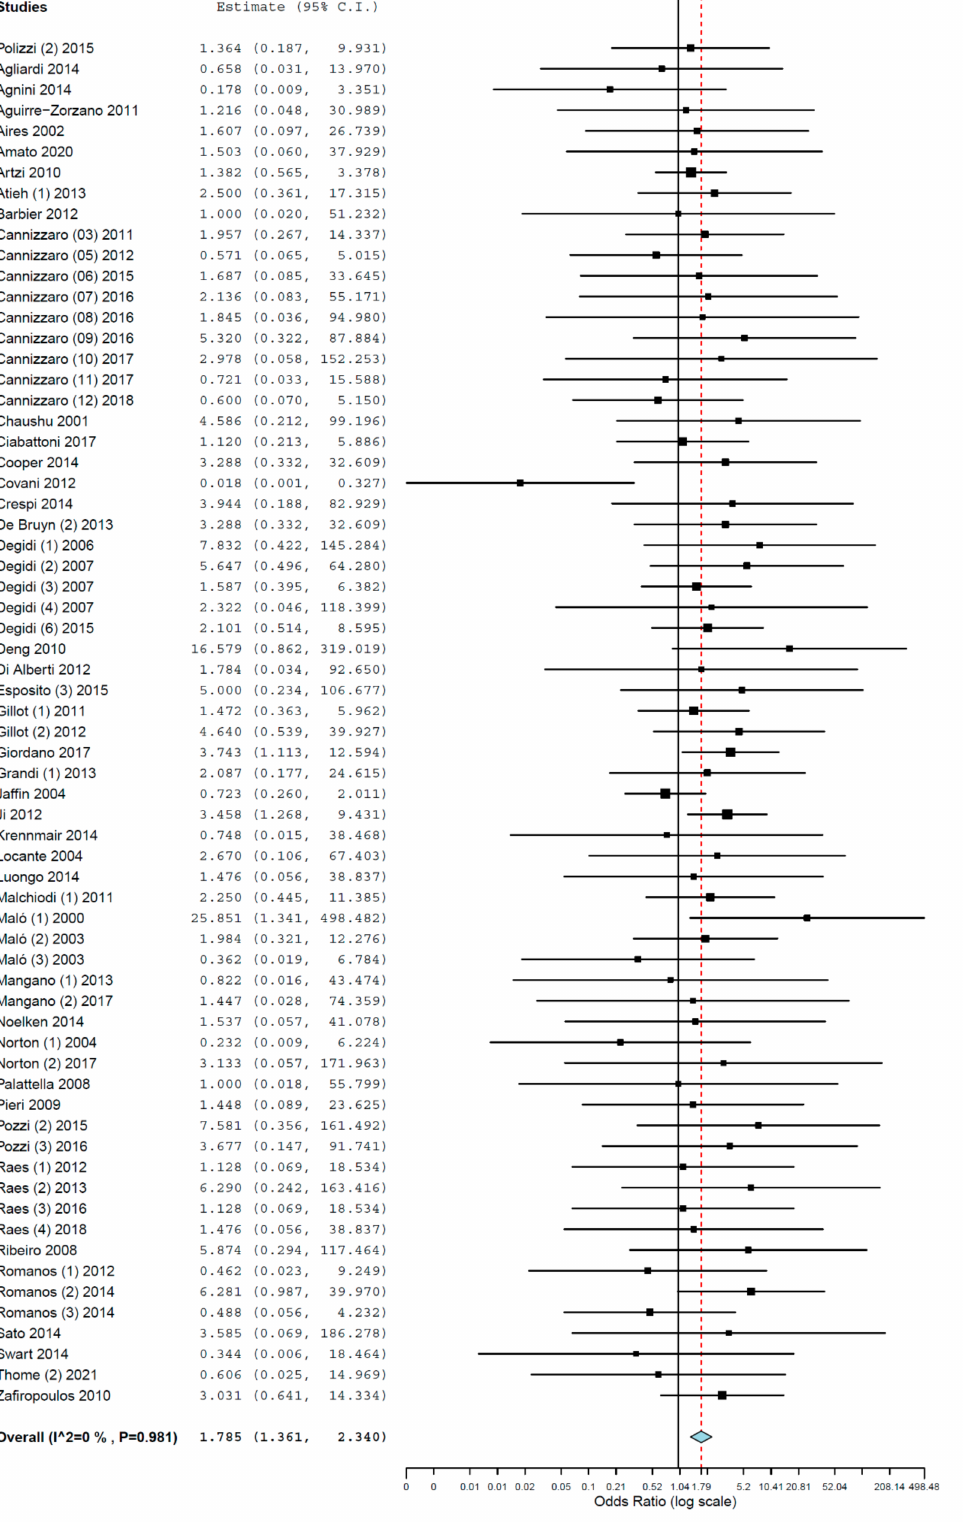
Figure 4. Forest plot for the event ‘implant failure’, studies evaluating implants immediately loaded exclusively. Estimate in Odds